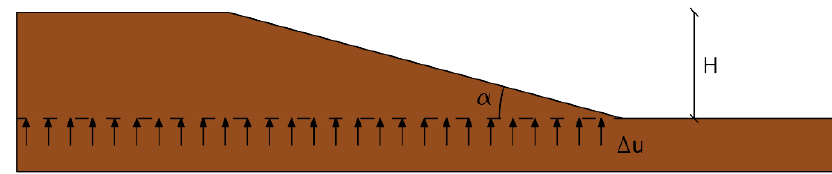
Figure 5. Slope model considered in the analysis. α : inclination angle; H: slope height.